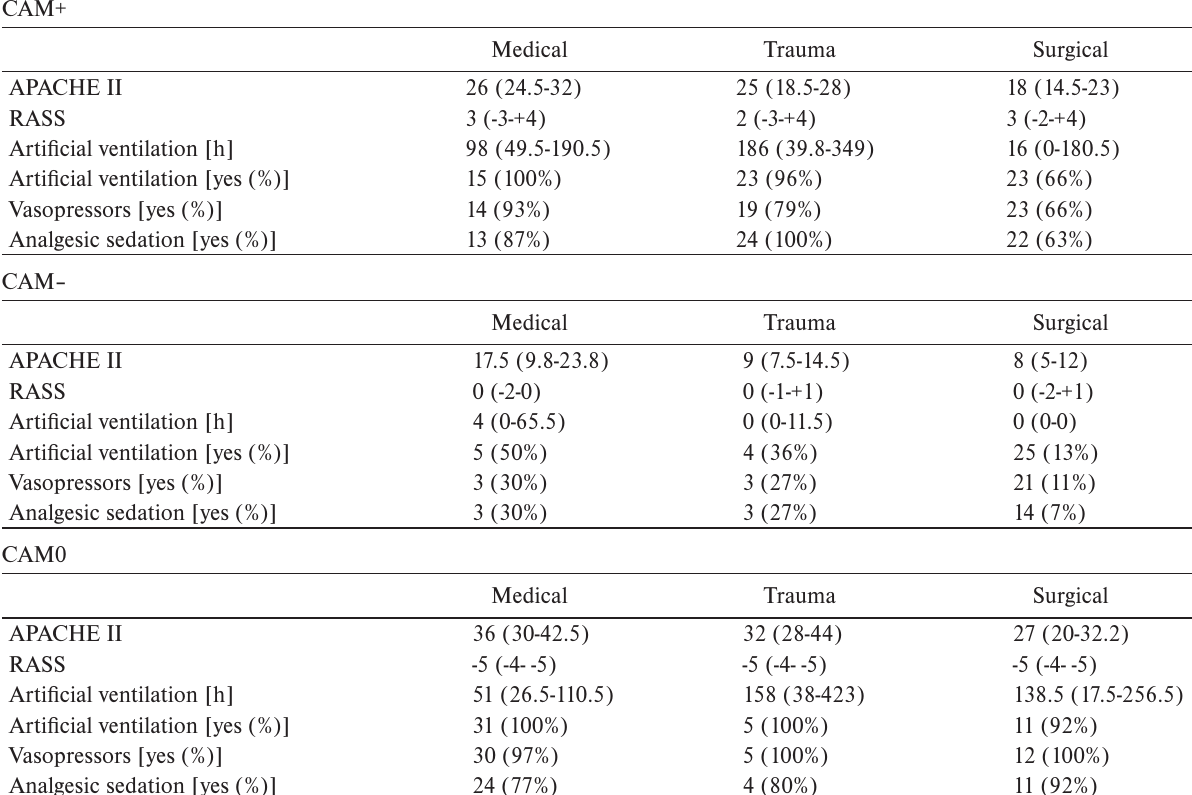
Table 4. Composition of study